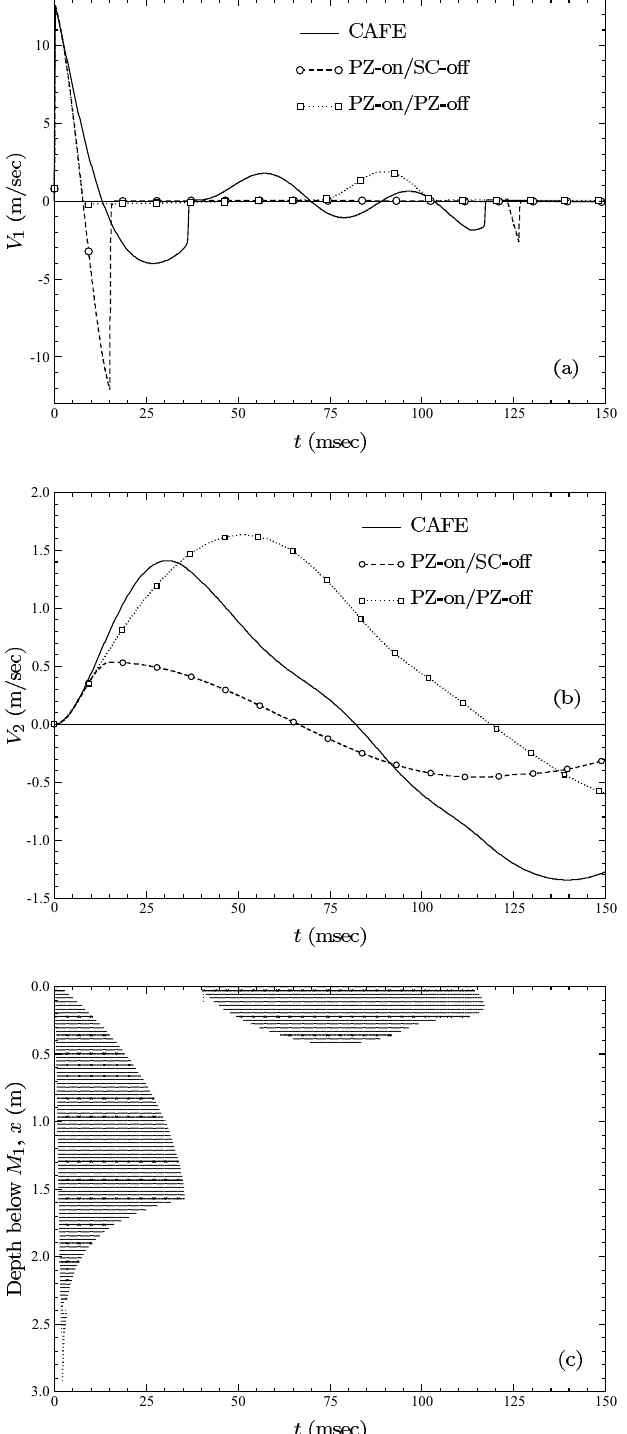
Fig. 7. (a) V 1 - and (b) V 2 -response histories for M 2 /M 1 = 25 , demonstrating the performance of two WSAs (PZ – Pressure Zero, SC – Separation Closure). (c) Cavitation